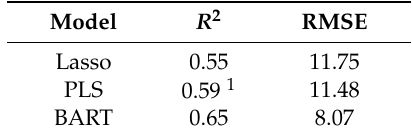
Table 4. Model selection monthly PM coarse.